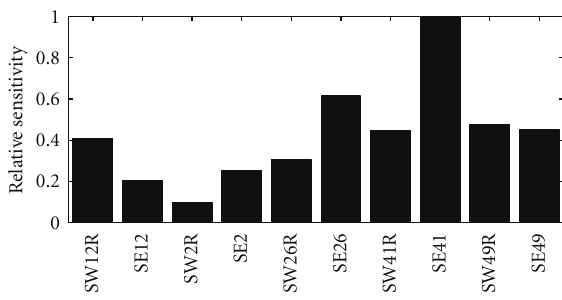
Figure 6: Relative sensitivity of the measurements with respect to the health